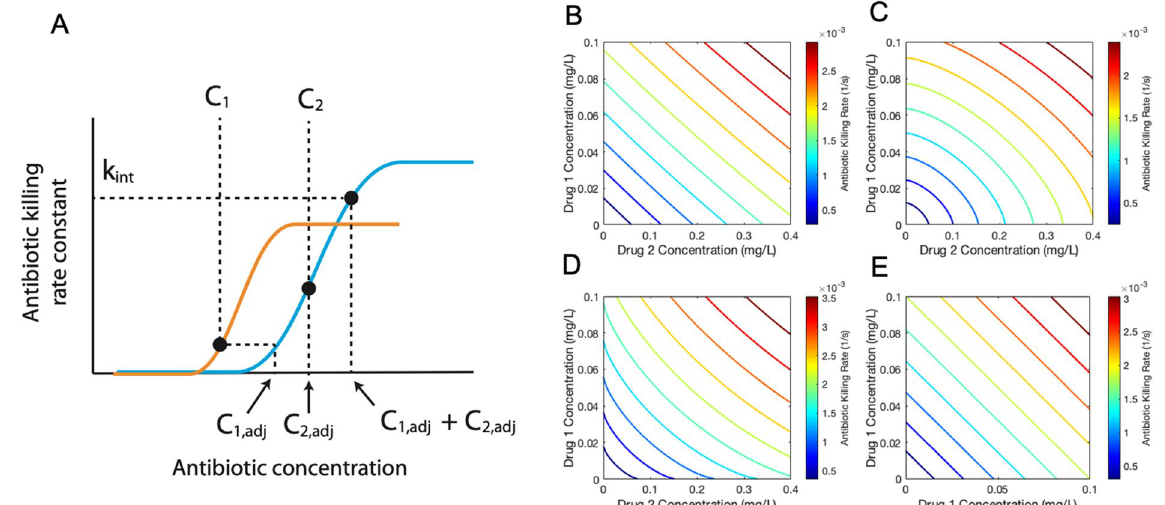
Figure 8. Graphical representation of computing the adjusted concentration and killing rate constant (Eqs. 1 and 3). The adjusted concentration of a drug is found by computing the equipotent concentration for another drug. The plot of two Hill curves for three different drugs (drug 1, orange; drug 2, blue) shows the relationship between concentrations of the two antibiotics and their adjusted concentration ( A ). The effective concentration, evaluated as the sum of the adjusted concentrations, determines the antibiotic killing rate constant. Antibiotic killing rate constant contours show the behavior of the drug interaction model for a combination of two theoretical drugs. Drug 1 has a c50 of 1 mg/L, E max of 0.02 1/s, and a Hill coefficient of 1. Drug 2 has a c50 of 2 mg/L, E max of 0.01 1/s, and a Hill coefficient of 1. When the two drugs have an FIC of 1.0 ( B ), 1.5 ( C ), or 0.6 ( D ), the contours show the characteristic straight line or curved contours characteristic of checkerboard assays for additive, antagonistic, or synergistic combinations. A sham combination of Drug 1 ( E ) results in a simply additive case. Contour plots were made using MATLAB (R2019a) 45